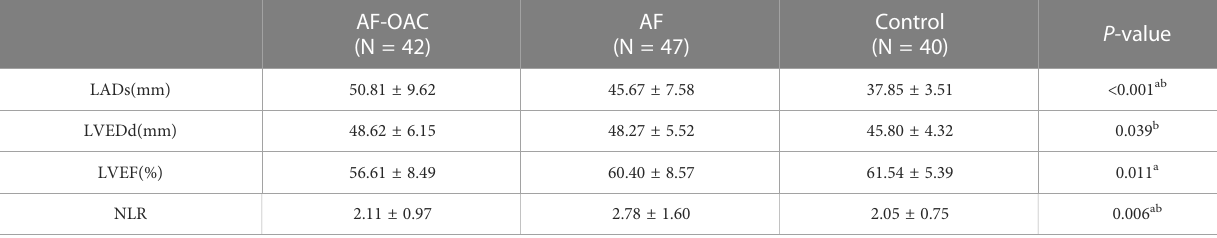
TABLE 2 Comparison of the in fl ammatory index and echocardiographic differences among the three groups ( x ̅ ± S).